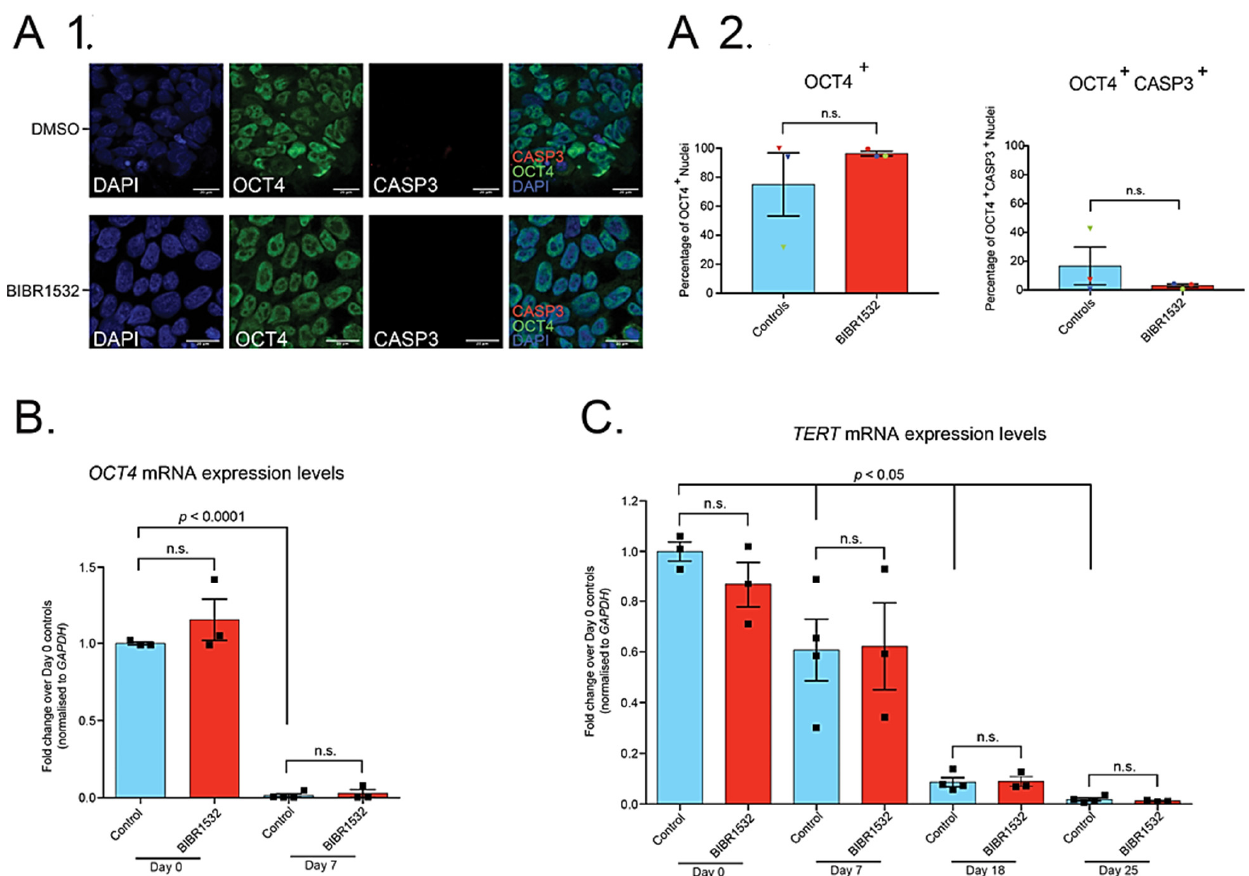
Figure 1. Treatment of iPSCs with 0.05 µM BIBR1532 allows continued culture, maintains pluripotency, and does not induce apoptosis; however, 0.05 µM BIBR1532 has no effect on TERT expression throughout iPSC-MN directed differentiation. ( A1 ) Qualitative immunocytochemistry for DAPI, OCT4, and activated CASP3 in iPSCs treated with 0.05 µM BIBR1532 or DMSO for 15 days. Scale bars = 20 µm. ( A2 ) Quantitative analysis of the percentage of OCT4 + nuclei and OCT4 + CASP3 + nuclei in 0.05 µM BIBR1532 treated iPSCs and DMSO controls. Data presented as mean ± S.E.M. Unpaired t -test. Three biological repeats (represented by datapoints), five fields per cover slip. ( B ) qRT-PCR analysis of OCT4 expression at day 0 and day 7 of neural induction, in cells treated with 0.05 µM BIBR1532 or DMSO, normalised over GAPDH expression, relative to day 0 control iPSCs. ( C ) qRT-PCR analysis of expression of TERT throughout iPSC-MN differentiation in cells treated with 0.05 µM BIBR1532 or DMSO, normalised to GAPDH expression, relative to day 0 control iPSCs. ( B , C ) Data presented as mean ± S.E.M. One experimental block, three biological replicates. Datapoints represent biological replicates. From day 7 onwards, an additional technical replicate of the Ctrl 1 line was included in controls, represented as an additional datapoint above. Two-way ANOVA, with Tukey’s test for multiple comparisons. n.s. = non-significant, with significance placed at a p -value of <0.05. p -values displayed graphically refer to the statistical difference between the indicated timepoint and day 0 control samples.